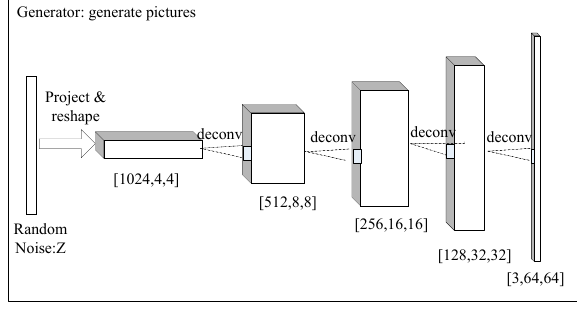
Figure 3. The framework of the generator and discriminator model in Generate Adversarial Network.